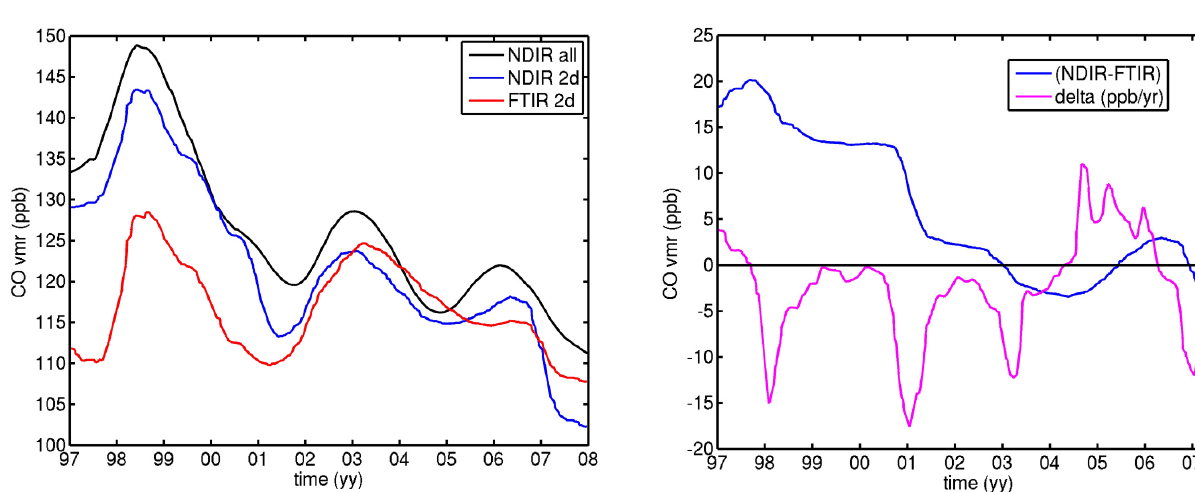
Fig. 7. Blue curve: Time series of the difference between NDIR and FTIR data. NDIR data have been defined according to a tem- poral overlap criterium with the FTIR data of ± 2 days. Magneta curve: KZ(74,5) smoothed gradient of the NDIR-FTIR difference as a function of